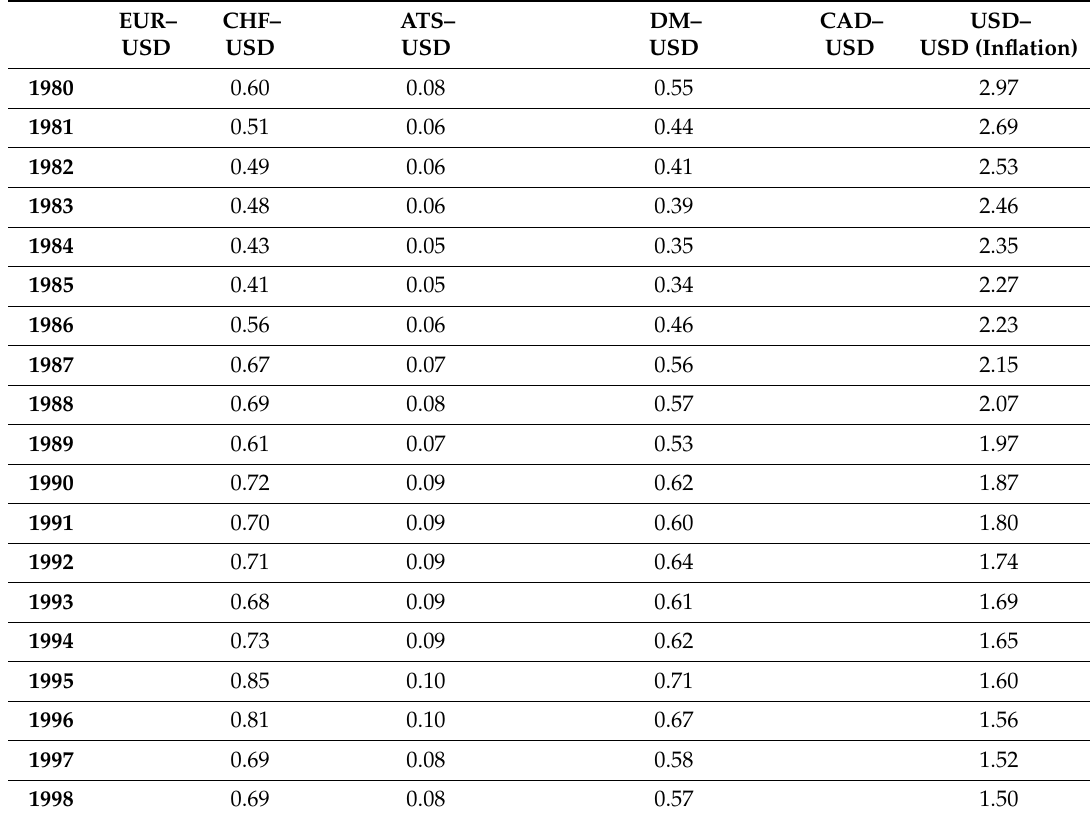
Table A1. Conversion rates for database values * (Source: http://www.in2013dollars.com/2016-